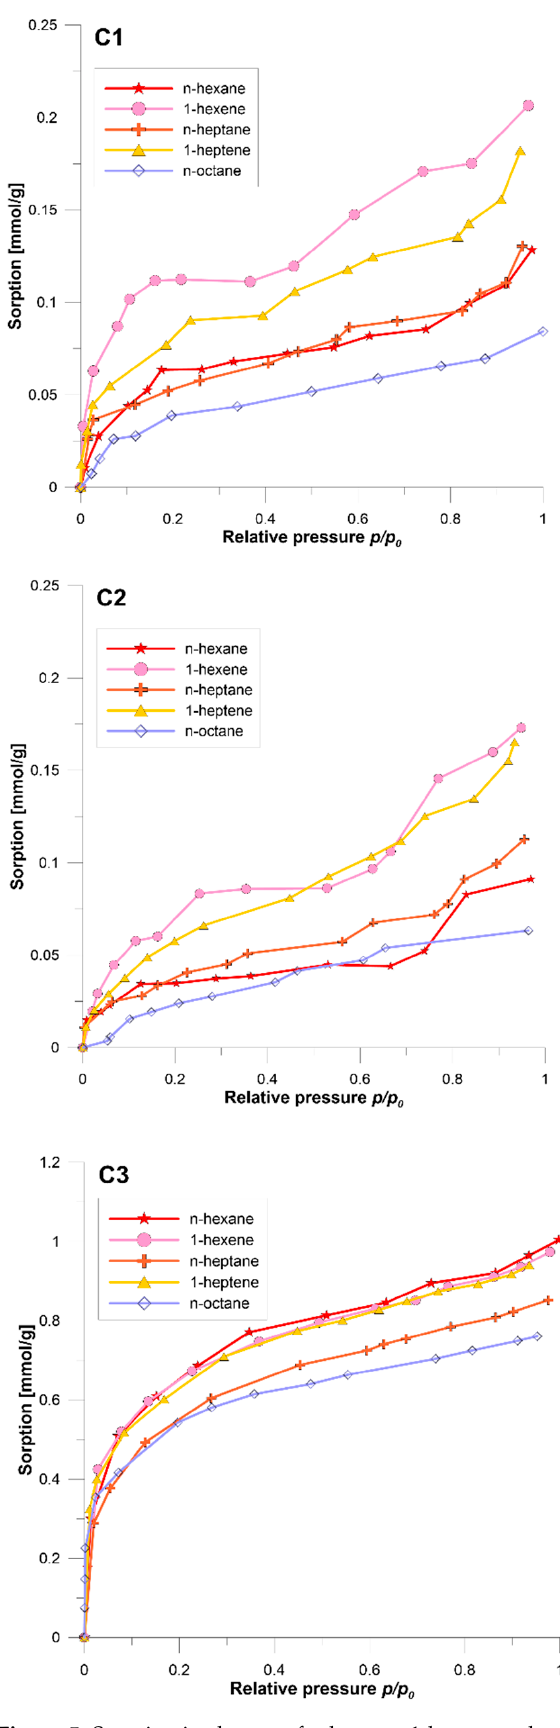
Figure 5. Sorption isotherms of n-hexane, 1-hexene, n-heptane, 1-heptene, and n-octane on coals: C1, C2 and C3.